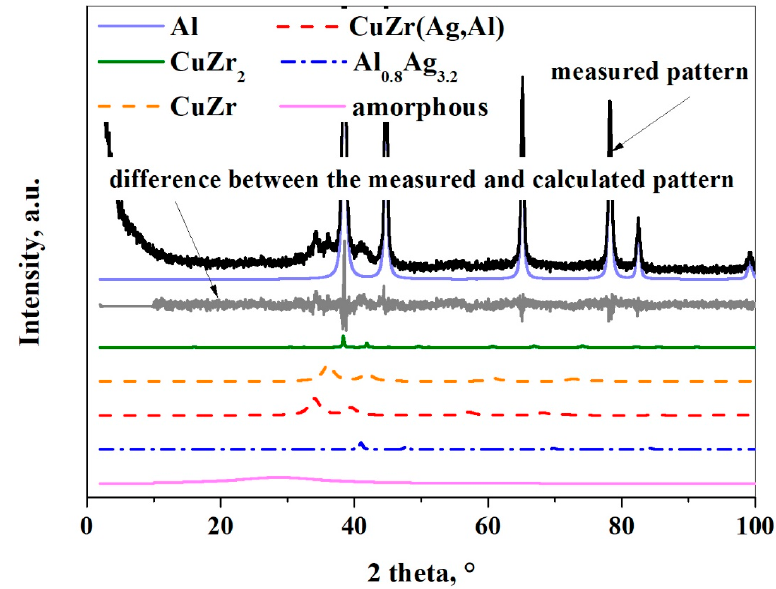
Figure 11. XRD pattern of the composite powder after 30 h of milling with using ethanol.